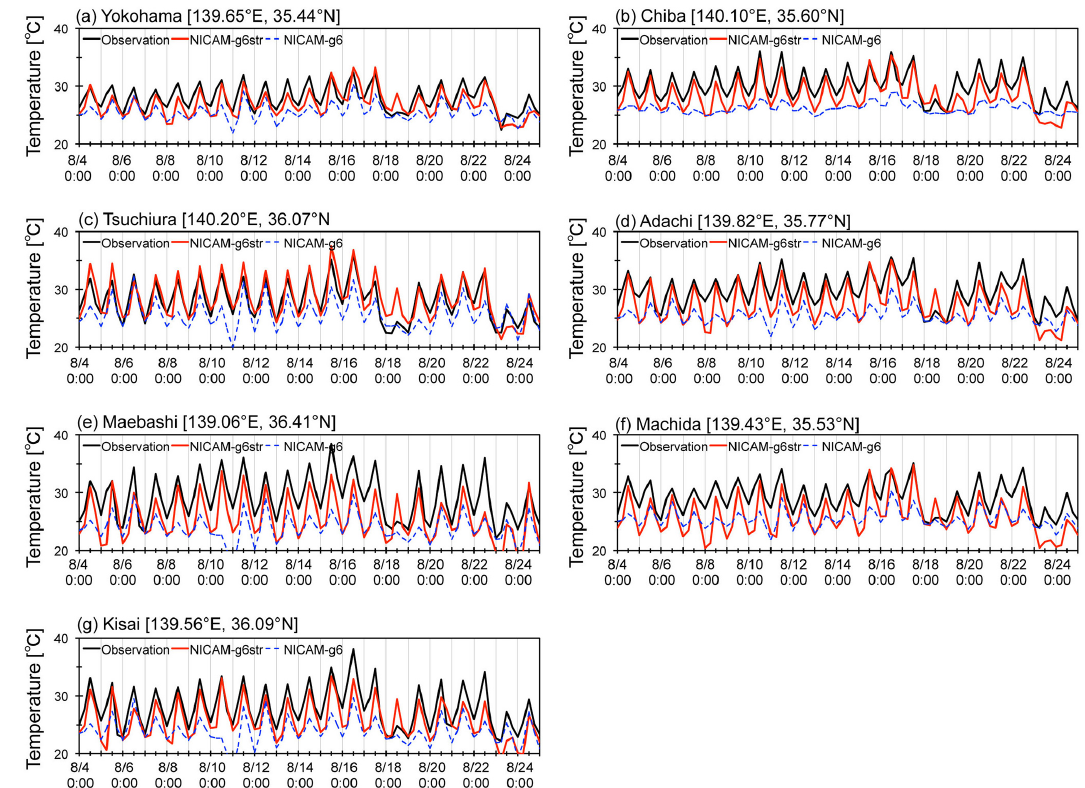
Figure 4. Temporal variations in the NICAM-g6str and NICAM-g6 simulated and observed air temperature for a height of 2m at (a) Yoko- hama, (b) Chiba, (c) Tsuchiura, (d) Adachi, (e) Maebashi, (f) Machida and (g) Kisai in August